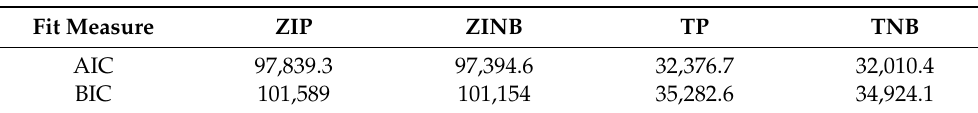
Table 8. AIC and BIC for the Zero-inflated Poisson (ZIP), Zero Inflated Negative Binomial (ZINB), Truncated Poisson (TP) and Truncated Negative Binomial (TNB) using state-wide